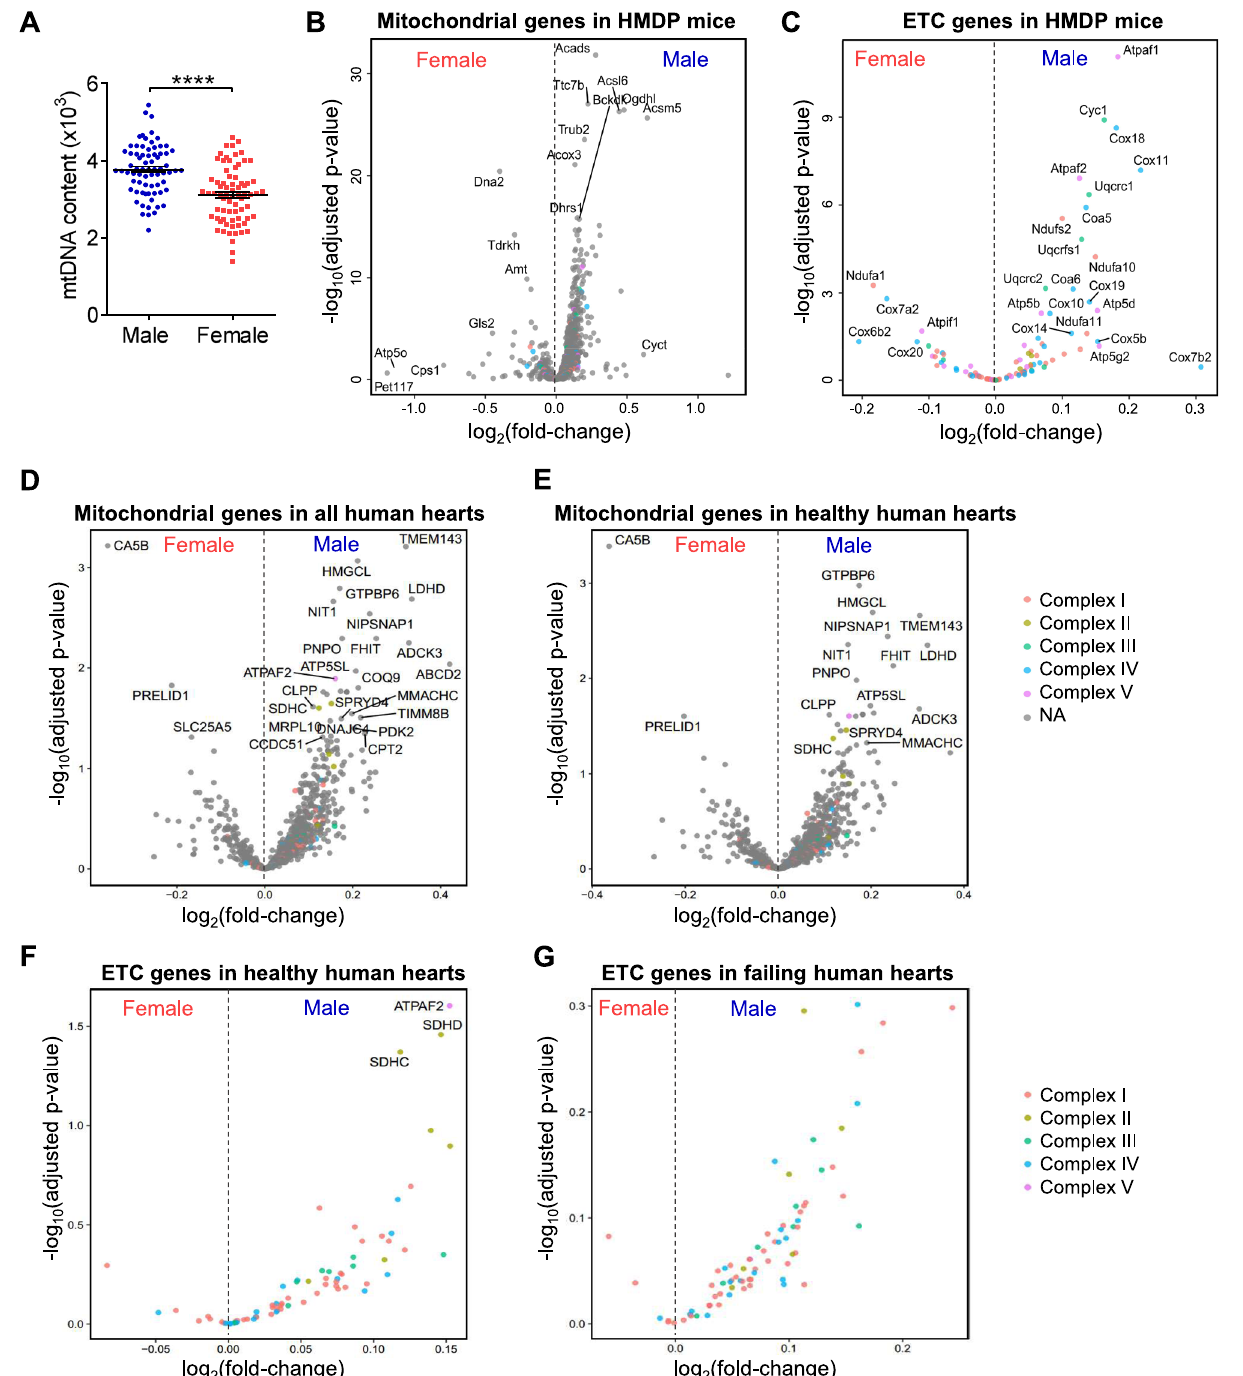
Fig. 2 Mitochondrial gene expression in human and mouse hearts. A Heart mtDNA copy number in male and female HMDP mice (about 10 weeks old). Each point represents a mouse from an inbred strain. N = 72. P < 0.0001. B , C Differential expressed genes encoding mitochondrial proteins ( B ) and electron transport chain (ETC) proteins ( C ) in 100 strains of HMDP mice. D , E Differential expressed mitochondrial genes in all human hearts ( D ) and healthy human hearts ( E ). F , G Differential expressed ETC genes in healthy ( F ) and failing ( G ) human hearts. Genes of each complex were denoted. All data are presented as the mean ± SEM. **** P < 0.0001 by two-sided Student ’ s t -test ( A ). DESeq2 results use the Wald test, corrected for false discovery rate (FDR) using the Benjamini – Hochberg (BH) method ( B – G ). Source data are provided as a Source Data fi